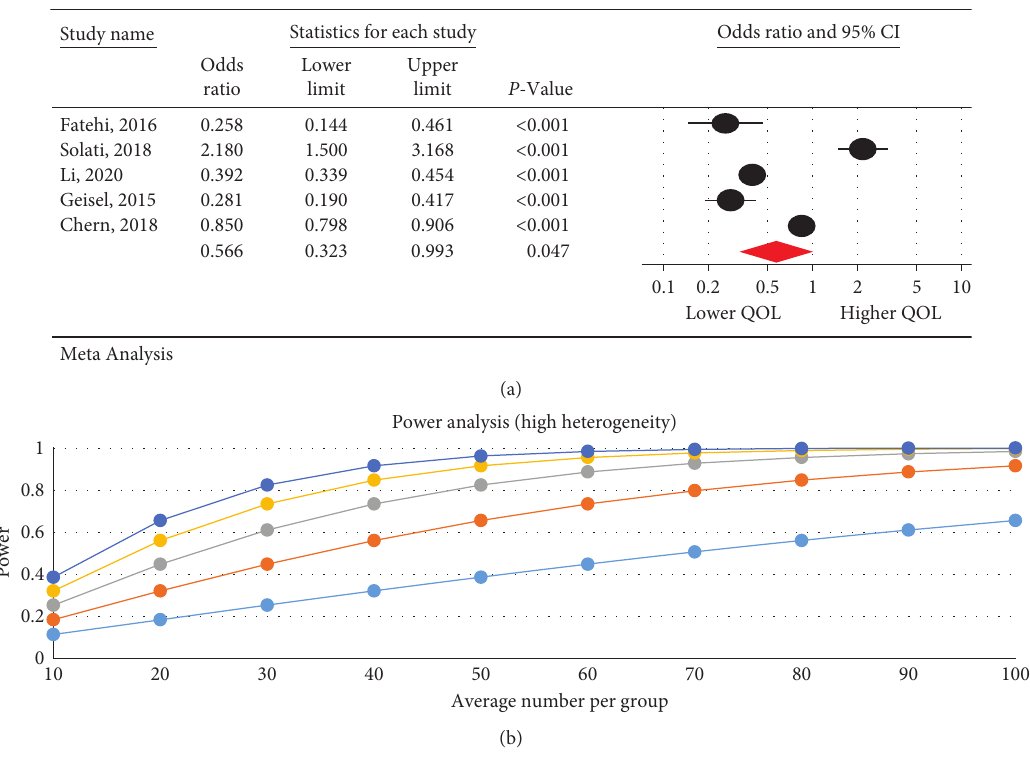
Figure 3: The relationship between the severity of internet addiction and the quality of life in the psychological dimension.